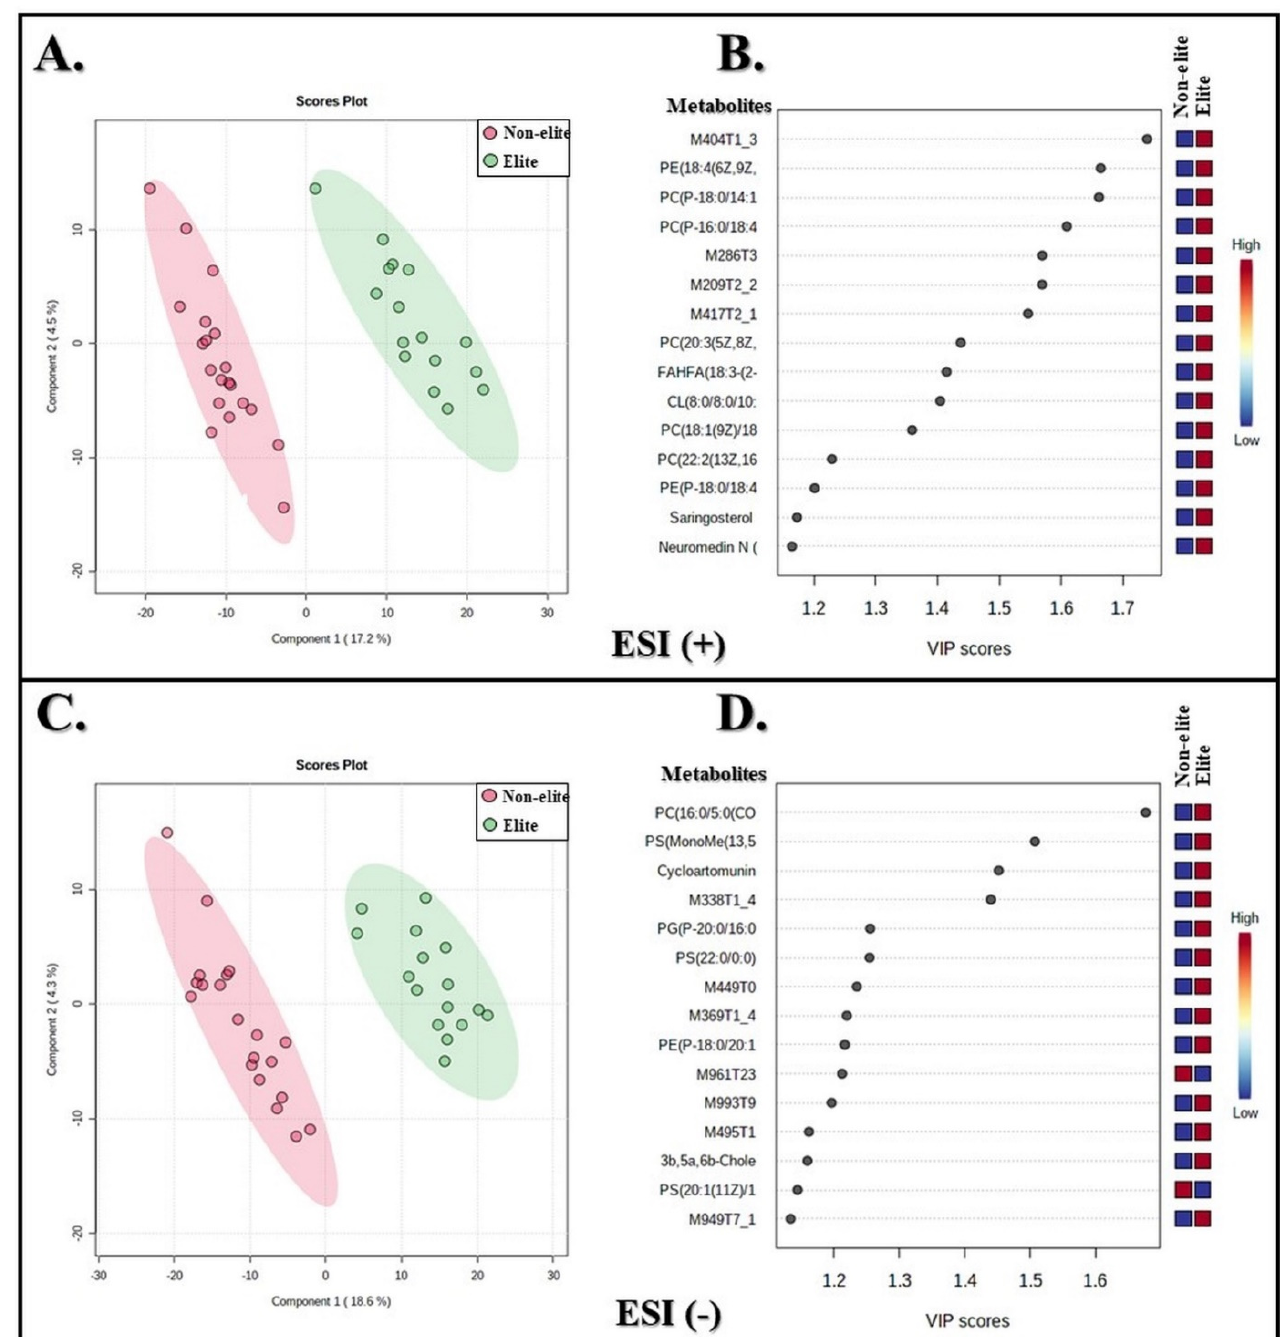
Figure 4. ( A , C ): 2D PLS-DA score plots comparing both groups in the ESI (+) and ESI ( − ) modes, respectively. ( B , D ): PLS-DA score plots showing the main features that discriminate the sample groups according to VIP scores for the ESI (+) and ESI ( − ) modes, respectively. The colors represent different soccer teams (red: non-elite athletes; green: elite athletes). The blue and red color spectrum boxes on the right indicate the values of relative abundances of the corresponding features in each team. Features M404T1_3, M286T3, M209T2_2, M417T2_1 in ESI (+) mode and M338T1_4, M449T0, M369T1_4, M961T23, M993T9, M495T1, M949T7_1 in ESI ( − ) mode were not